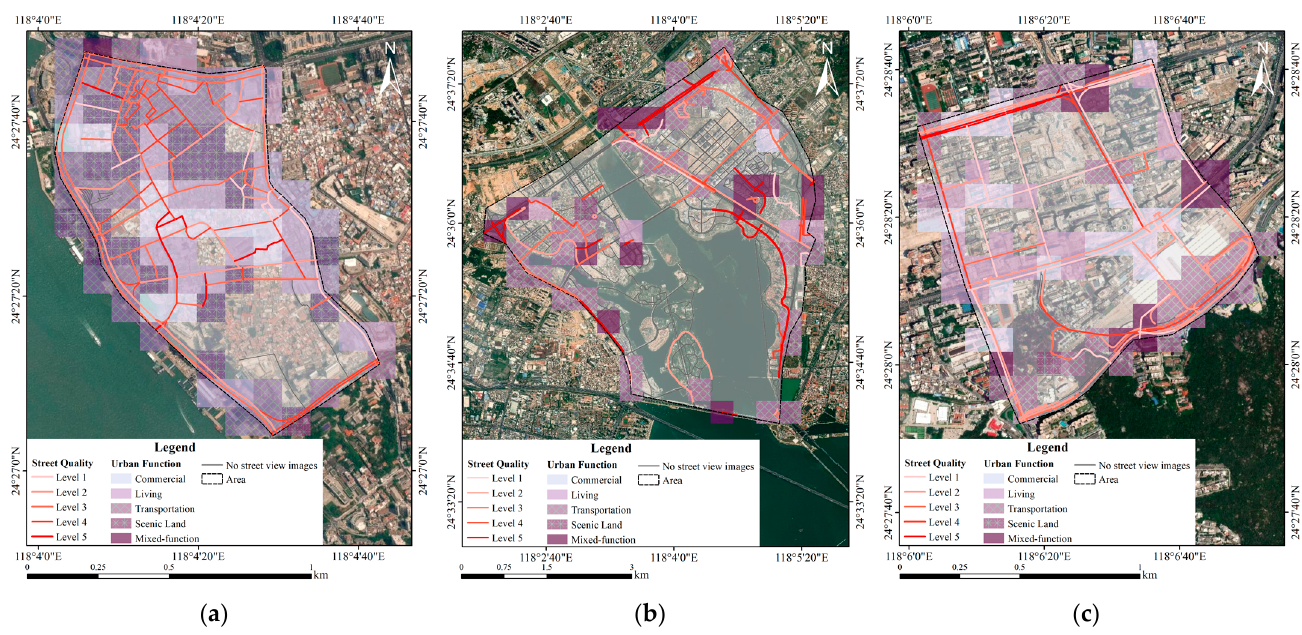
( c ) Figure 13. Visualisation results of street vitality measuring level in ( a ) Area Ⅰ , ( b ) Area Ⅱ , and ( c ) Area Ⅲ . 4.3. Street Quality Assessment The results of the street quality assessment are displayed in Figure 14. As shown in Figure 14, the urban function represents the five urban function detection results. For